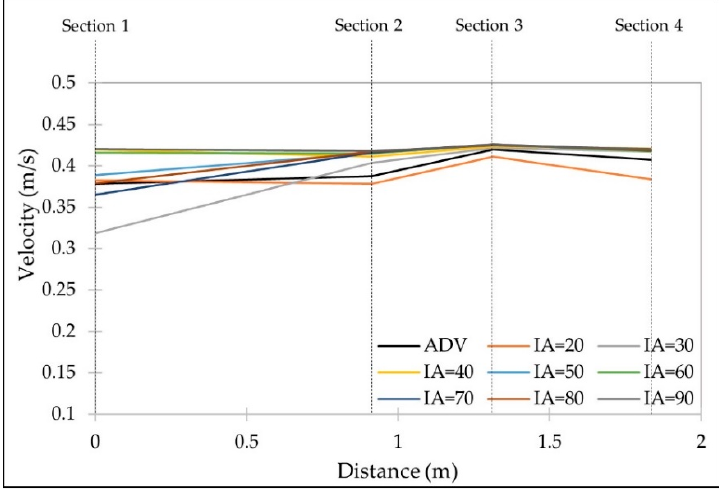
Figure 8. Measured Velocities obtained using LSPIV and ADV at Line-C (See Figure 5).